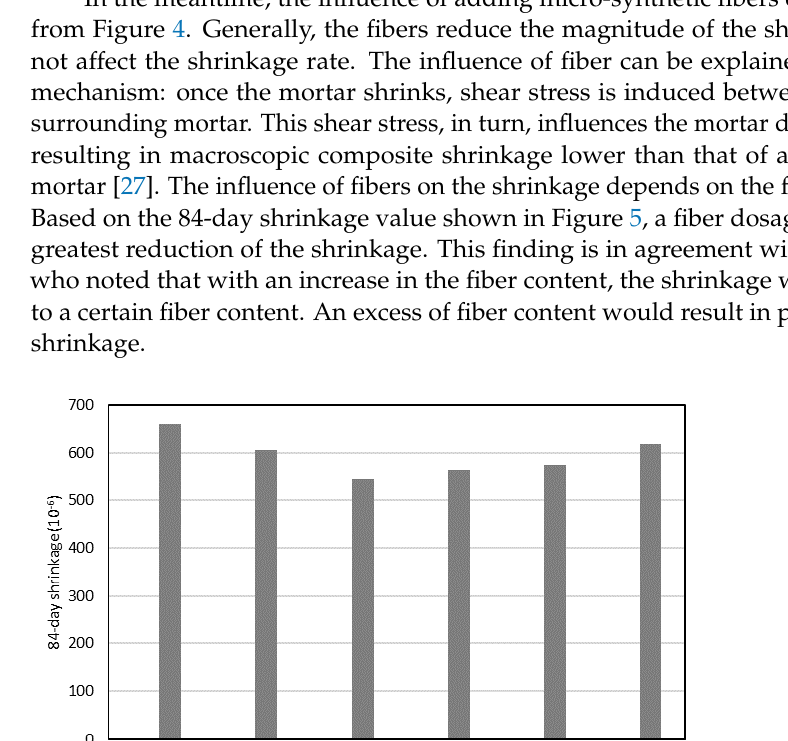
Figure 4. The shrinkage development with time.